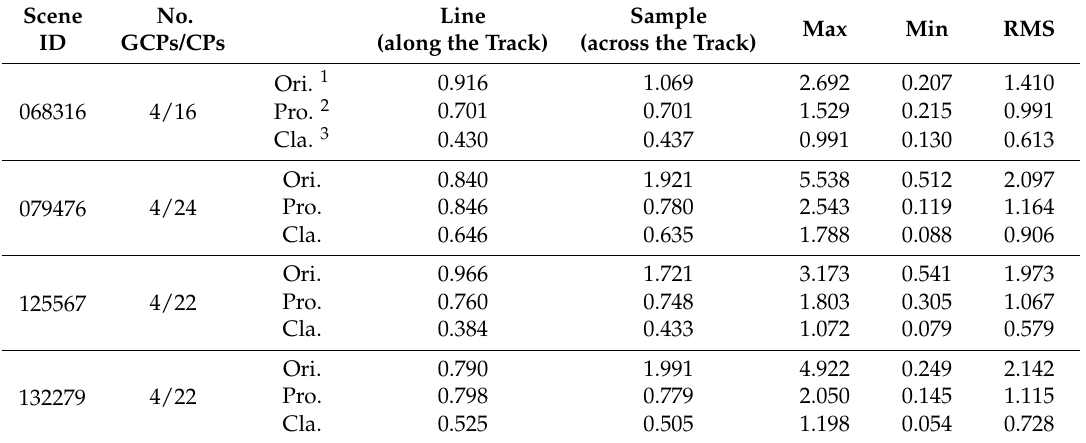
Table 5. Orientation accuracy with four ground control points (GCPs) (unit: